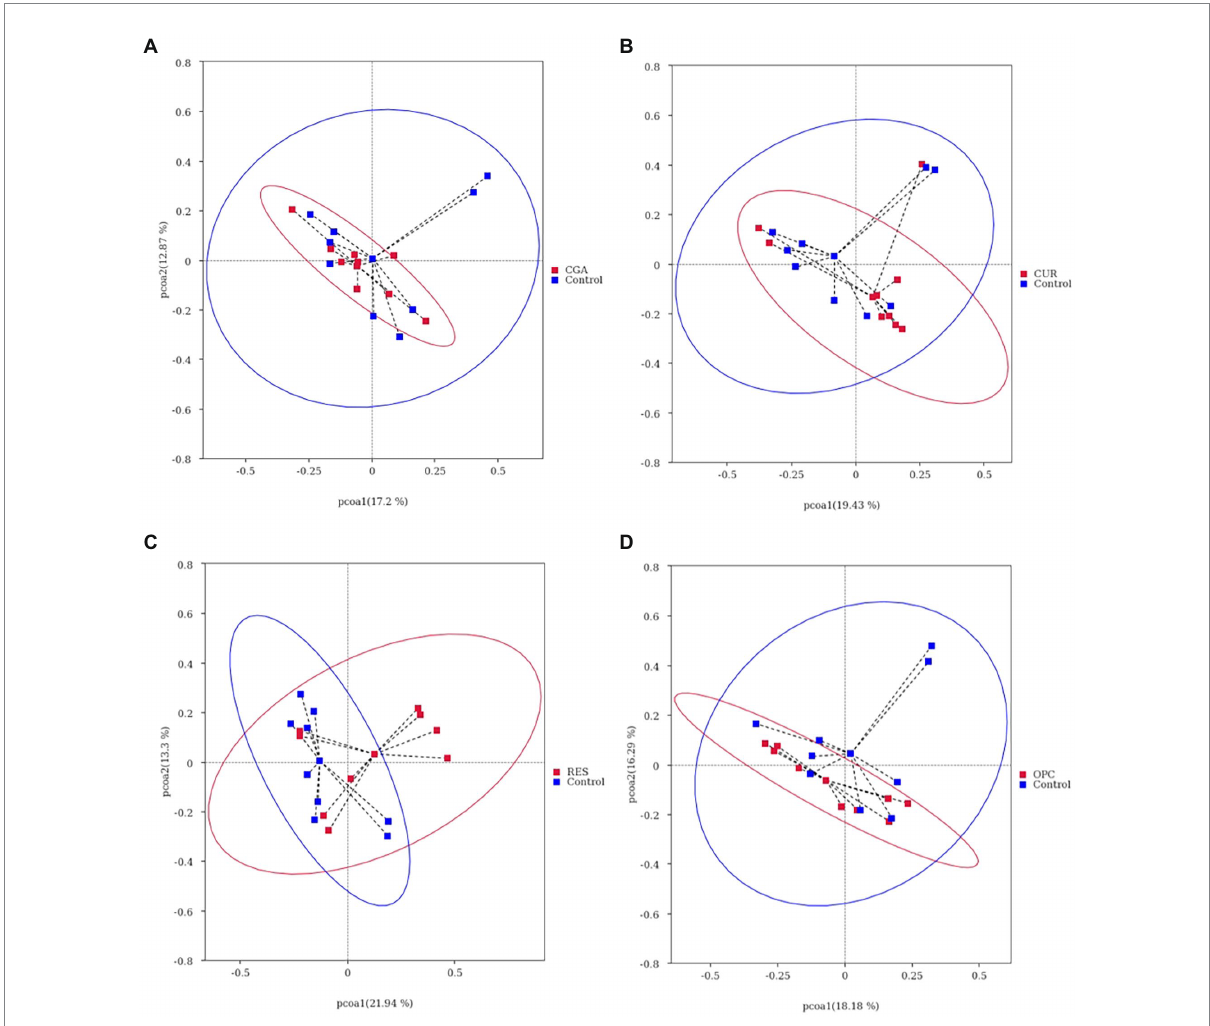
FIGURE 7 Gut bacterial community of fish between (A) CUR and control; (B) OPC and control; (C) CGA and control; (D) RES and control, differentiated using a principal coordinate analysis based on bray crutis distances ( n = 9 per treatment). CON, control group; CUR, curcumin group; OPC, oligomeric proantho cyanidins group; CGA, chlorogenic acid group; RES, resveratrol